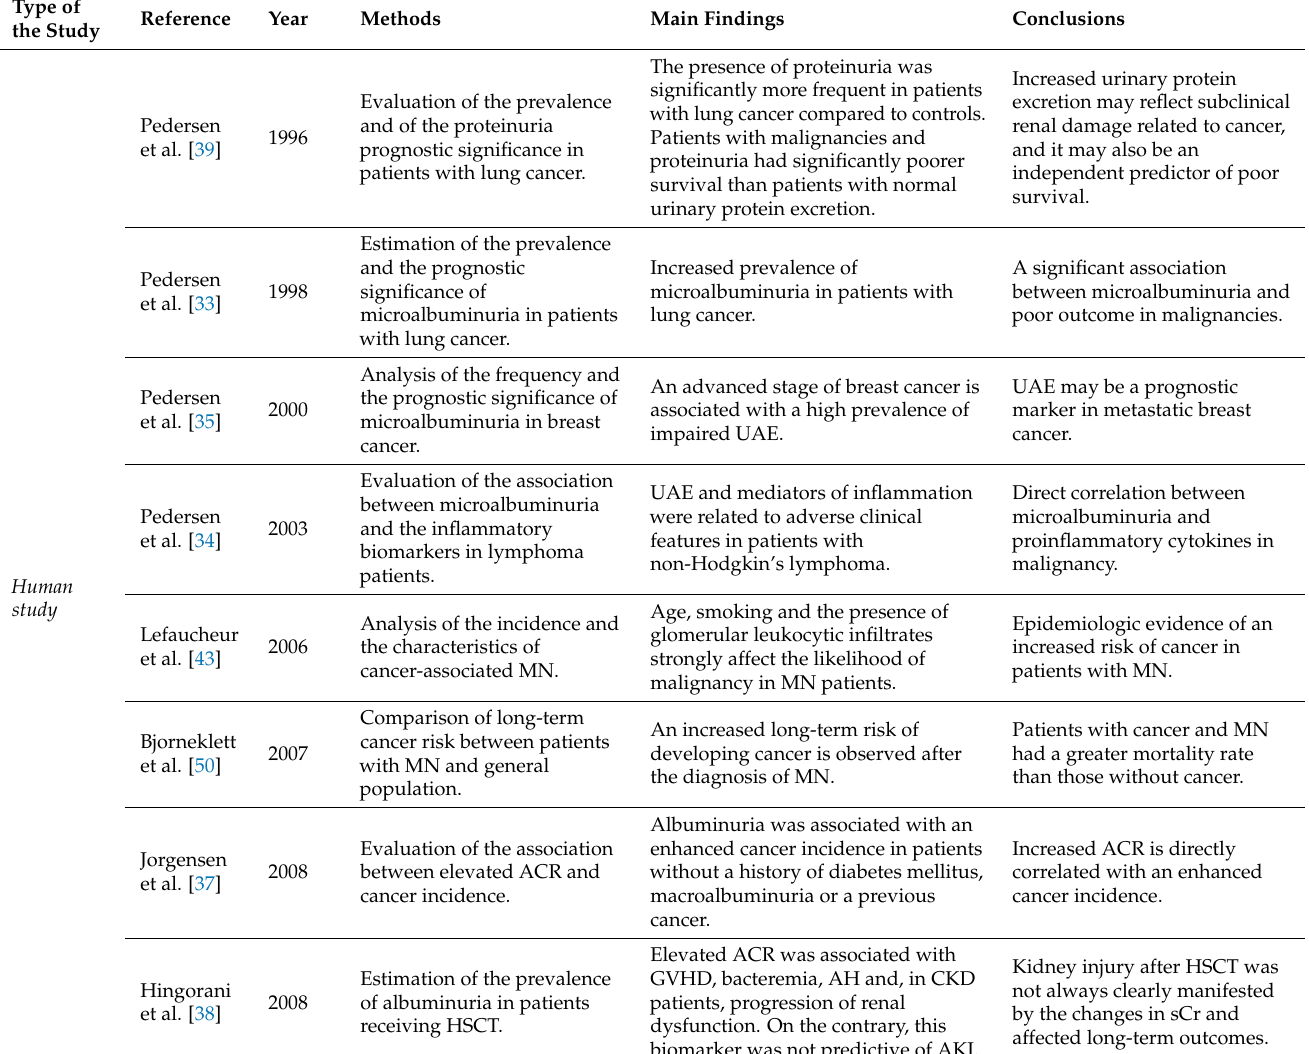
Table 1. Main studies on the relationship between glomerular disease and